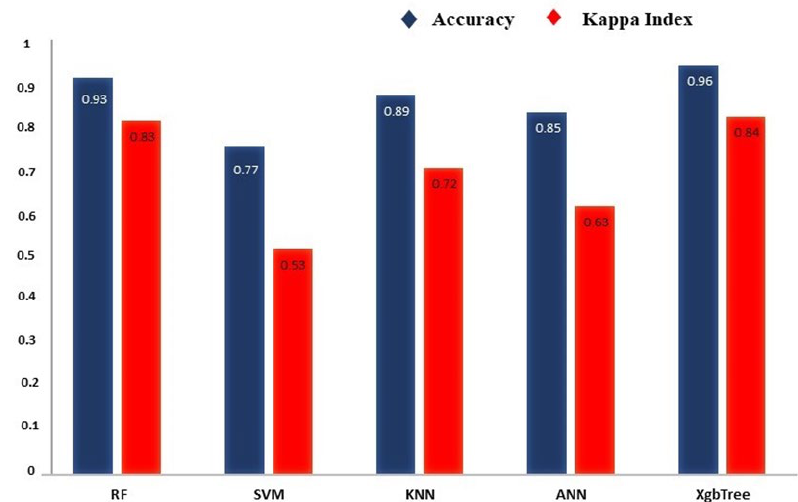
Figure 9. Bar plot for Accuracy and Kappa index.